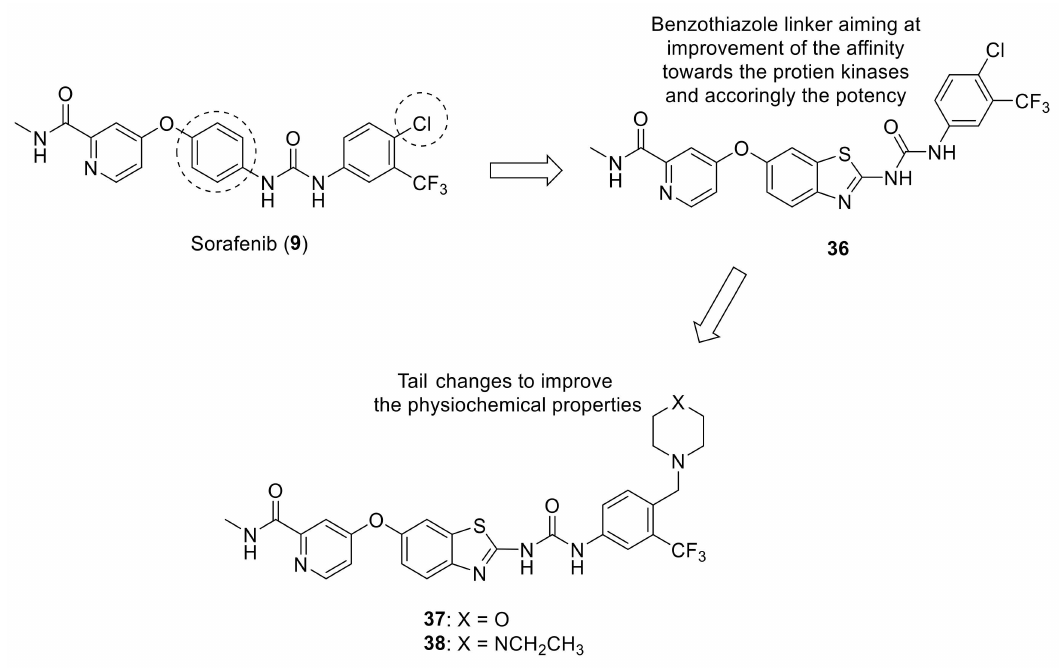
Figure 14. Structure-based design strategy of compounds 36 – 38 derived from sorafenib ( 9